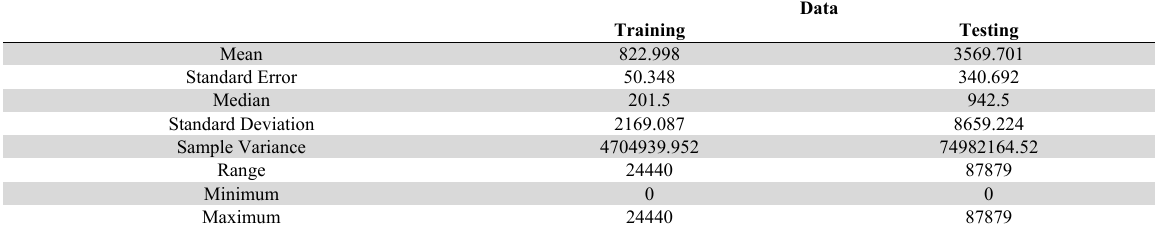
Statistical characteristics of training and testing